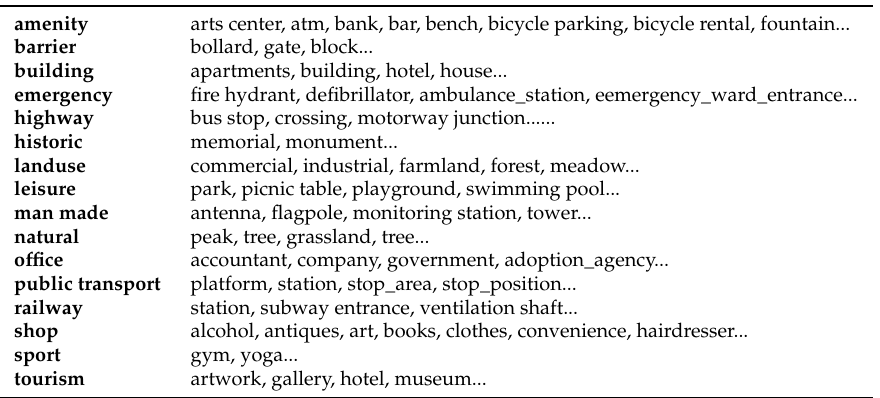
Table 1. Attributeinformation of POI data (collected from Open Street Map data; the left side of the table shows POI object attributes, and the right side is the corresponding sub-class under the attribute).